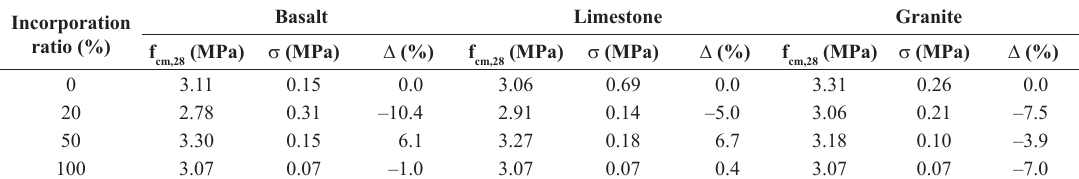
Table 5. Splitting tensile strength.